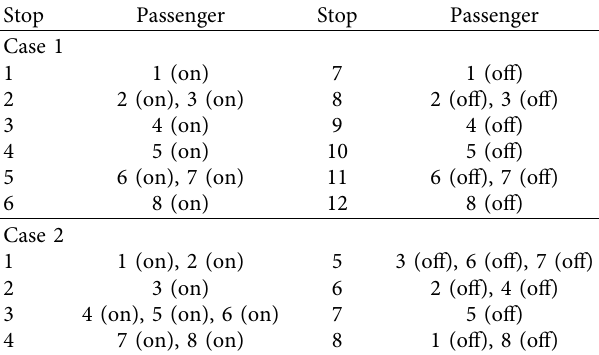
Table 2: Passengers’ boarding and alighting stops in Case 1 and Case